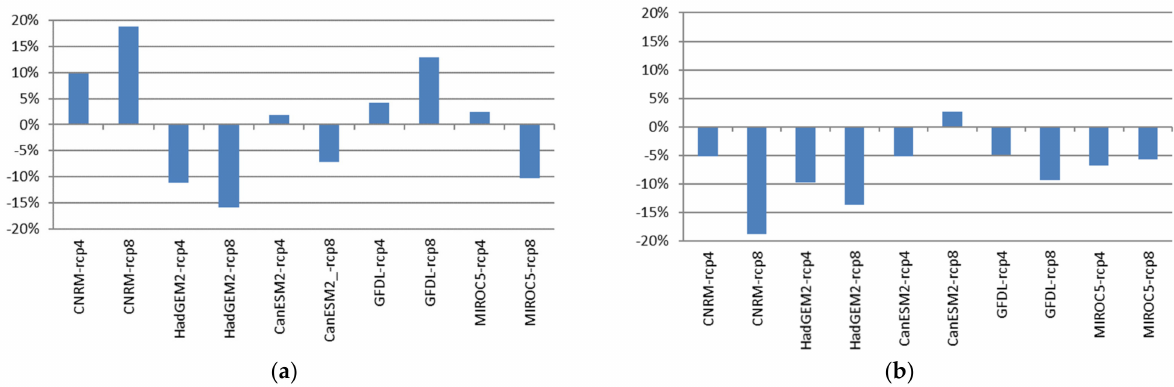
Figure 5. Changes in annual discharge: ( a ) 2010–2039, ( b )